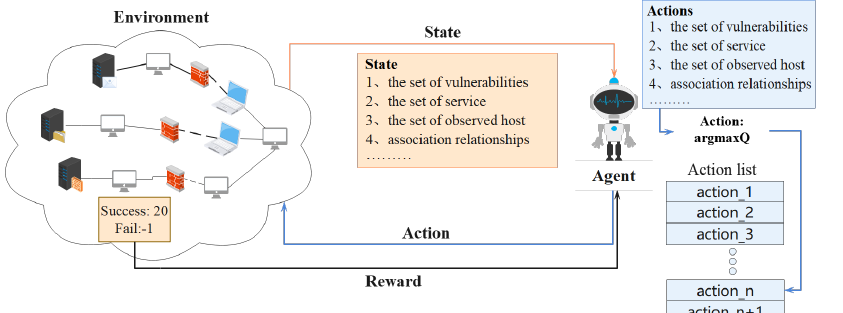
Figure 1. The agent interacts with the environment. When the agent observes the environment’s state, the agent chooses an action from the list of actions pulled by the maximum Q-value requirement, which is the target of RL algorithms. Then, the agent obtains the reward, which depends on the action’s execution. The environment’s state changes to a new state and the next step